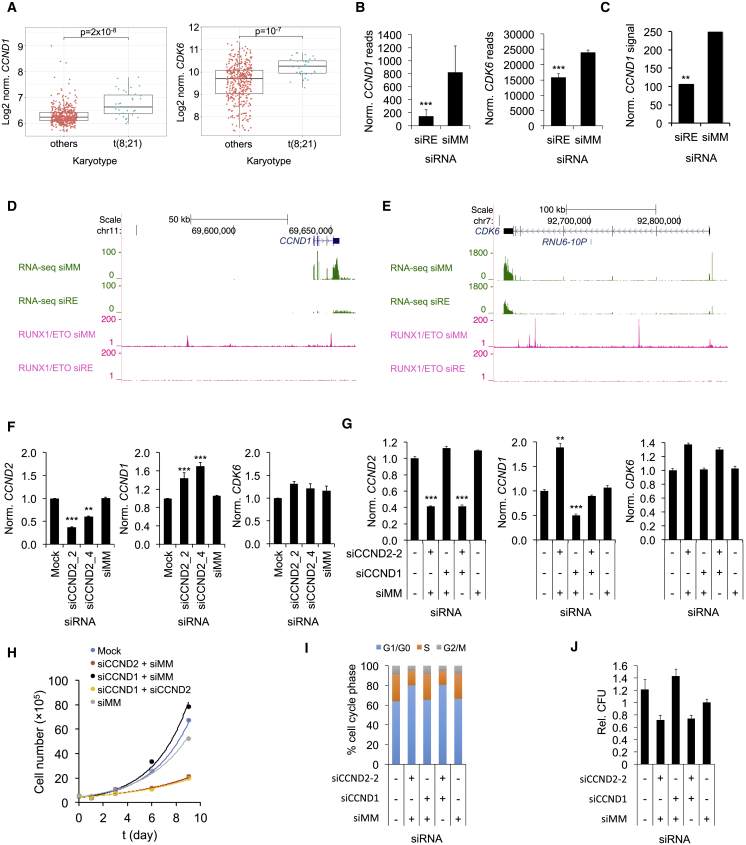
G1 Cell Cycle Components Are Regulated by RUNX1/ETO but Do Not Compensate for CCND2 Loss(A) Comparison of CCND1 and CDK6 expression between patients with t(8;21)-positive and -negative AML. Line, median; horizontal box, interquartile range; whiskers, 1.5× interquartile range. p value was determined by Mann-Whitney U test. Data were obtained from GEO GSE6891.(B) CCND1 and CDK6 expression with and without RUNX1/ETO knockdown in Kasumi-1 cells as indicated by RNA-seq. siRE, RUNX1/ETO siRNA; siMM, mismatch control siRNA. Mean ± SD; n = 3. ∗∗∗p < 0.001.(C) CCND1 transcript levels in primary t(8;21) AML blasts upon RUNX1/ETO knockdown as analyzed by Illumina bead arrays with probe ILMN_1688480. ∗∗p < 0.01 compared with siMM.(D and E) RUNX1/ETO knockdown-induced changes in transcript levels and RUNX1/ETO binding at the CCND1 (D) and CDK6 (E) loci in Kasumi-1 cells as indicated by RNA-seq (green) and ChIP-seq (pink), respectively. Top, scale and base pair position on chromosome.(F) Impact of CCND2 knockdown by two different siRNAs on indicated mRNA levels. Kasumi-1 cells were sequentially electroporated every 2 days with the indicated siRNAs. Transcript levels were determined on day 8 by qPCR. Mock, non-siRNA electroporated cells; siCCND1, siCCND2, CCND1, and CCND2 siRNA. Mean ± SD; n = 3. ∗∗∗p < 0.001; ∗∗p < 0.01 compared with siMM.(G) Effects of single and combined siRNA treatment on CCND2, CCND1, and CDK6 RNA levels in Kasumi-1 cells. Transcript levels were analyzed in triplicates 48 hr after electroporation by qPCR and normalized to GAPDH. Mean ± SD, n = 3. ∗∗∗p < 0.001; ∗∗p < 0.01 compared with siMM.(H) Proliferation curves for Kasumi-1 cells electroporated sequentially every 2 days with the indicated siRNA combinations.(I) Cell cycle distribution of Kasumi-1 cells 48 hr after electroporation with the indicated shRNA combinations. n = 1.(J) Colony formation of Kasumi-1 cells electroporated with the indicated sRNA combinations. Colonies were counted after 12 days post plating and normalized to siMM. Mean ± SD; n = 4 technical replicates.See also Figure S5.